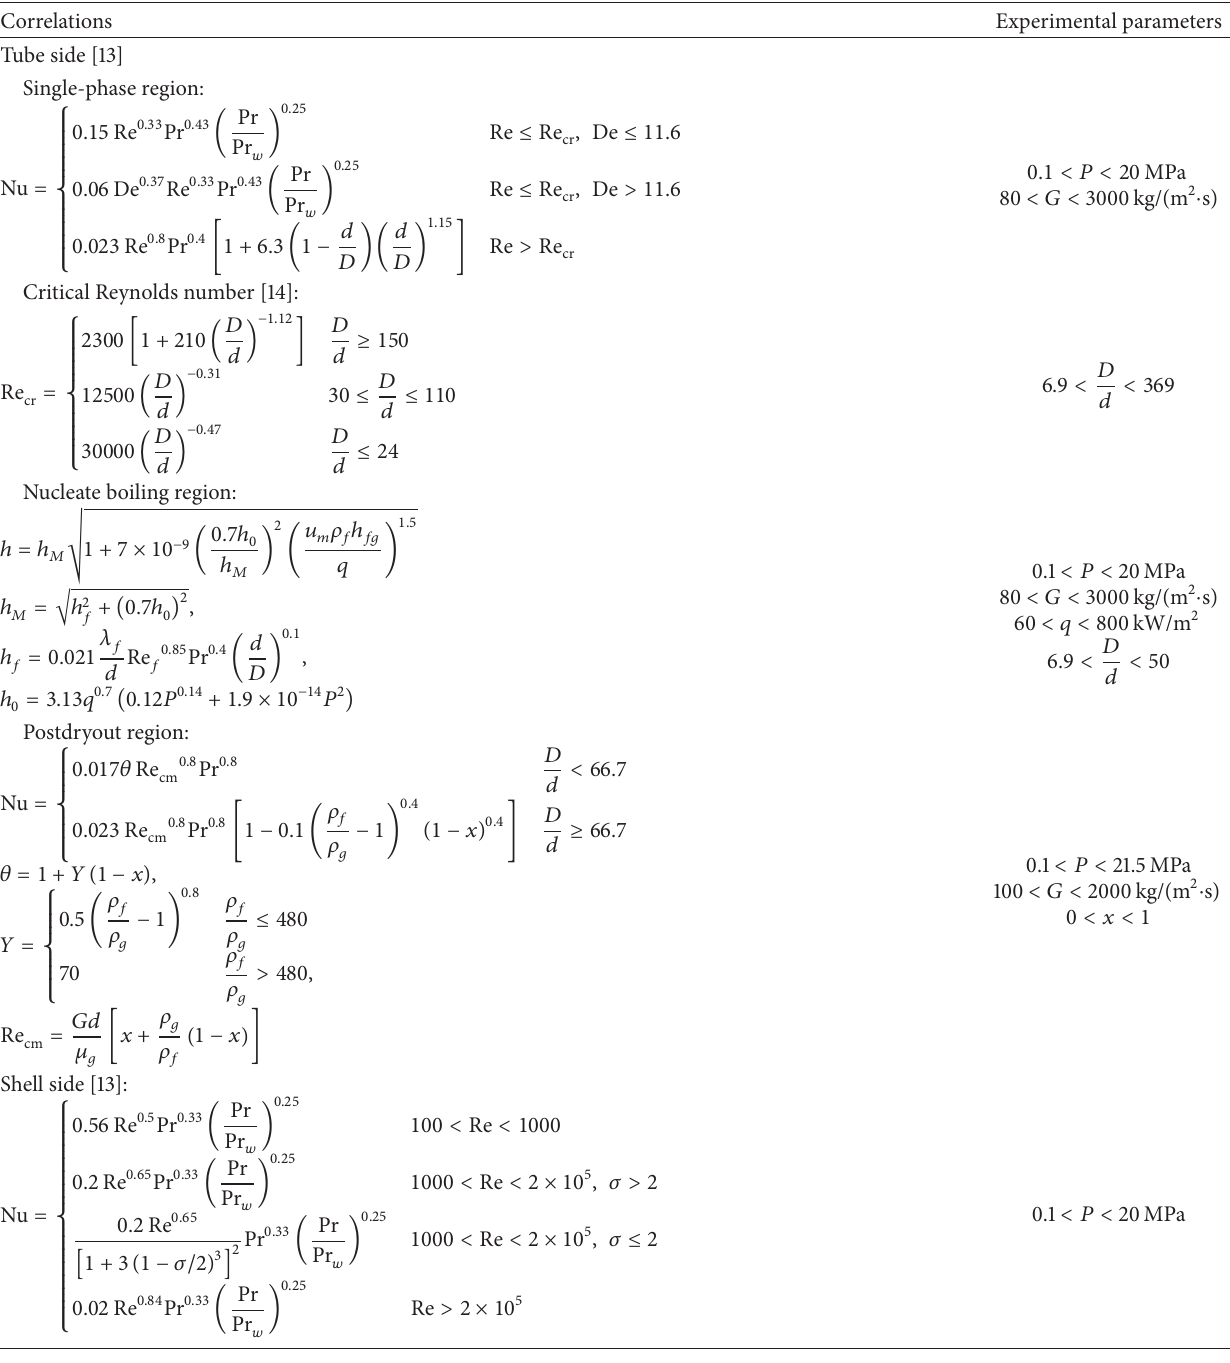
Table 1: Heat transfer correlations in the tube side and shell side of H-OTSG. Correlations Experimental